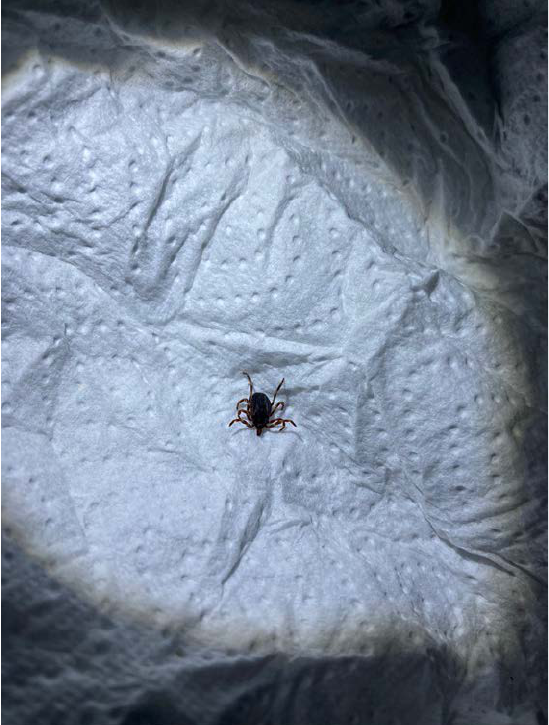
Figure 3. Example of picture sent via citizen science for further determination. Table 1. Species, sex and species of the host were identified in the case of ticks. Microorganisms were detected in the ticks. (CCHFV = Crimean-Congo-haemorrhagic fever virus, na = not available, neg = negative, pos = positive).